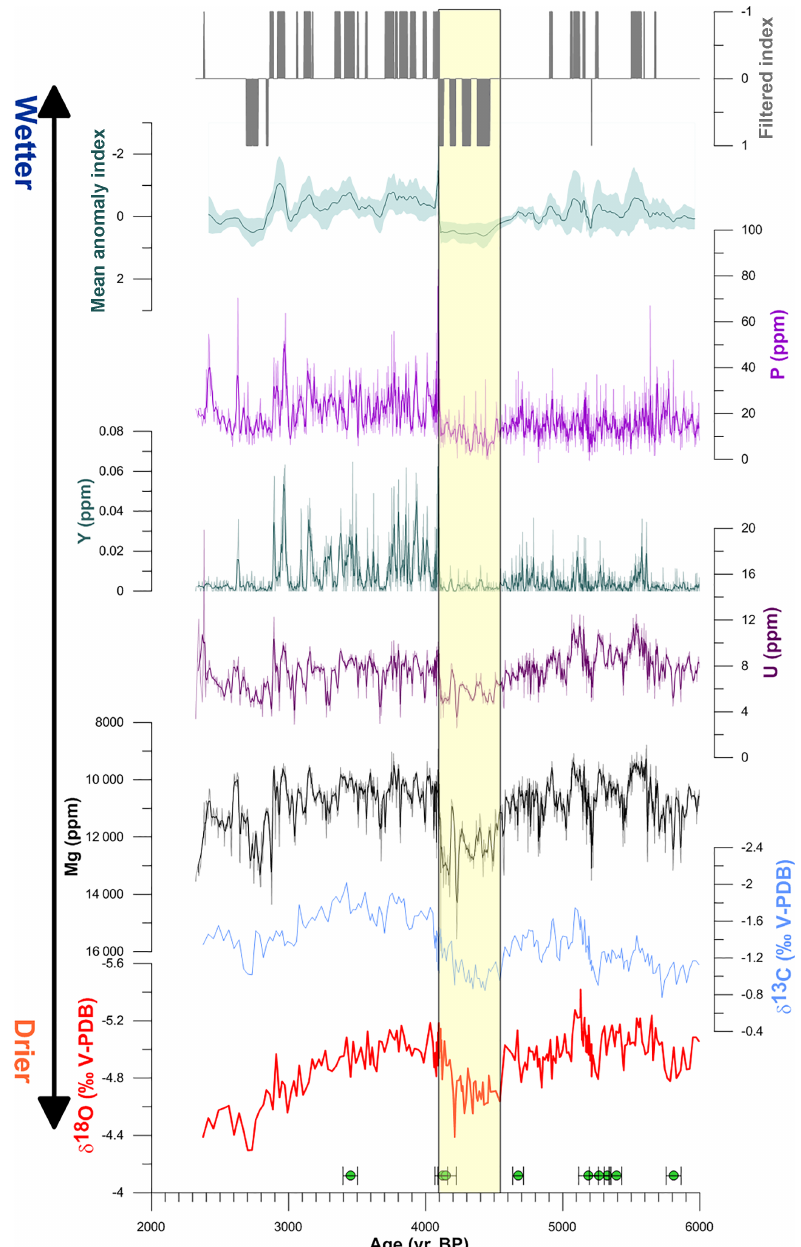
Figure 4. Time series of CC27 isotopes and trace elements. From the bottom: δ 18 O, δ 13 C, Mg, U, Y, P. Thick lines are 5-point running averages. Above the time series of the combined mean anomalies (referred to as MA time series in the main text) of trace elements (green line), error is expressed in standard deviation units (light blue strip), and on top is the square wave of the index of filtered anomalies (referred to as FI time series in the main text). Green dots represent U–Th ages, horizontal bars 2 σ errors. The yellow box represents the 4.2ka interval as recorded by CC27